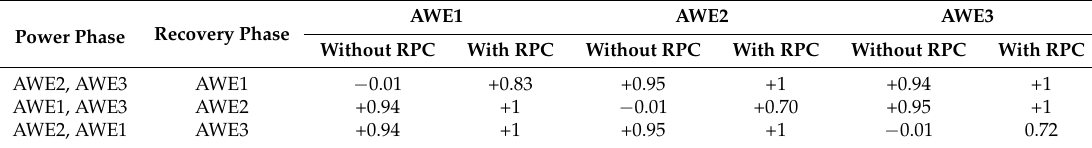
Table 2. Average power factors of AWE units with and without